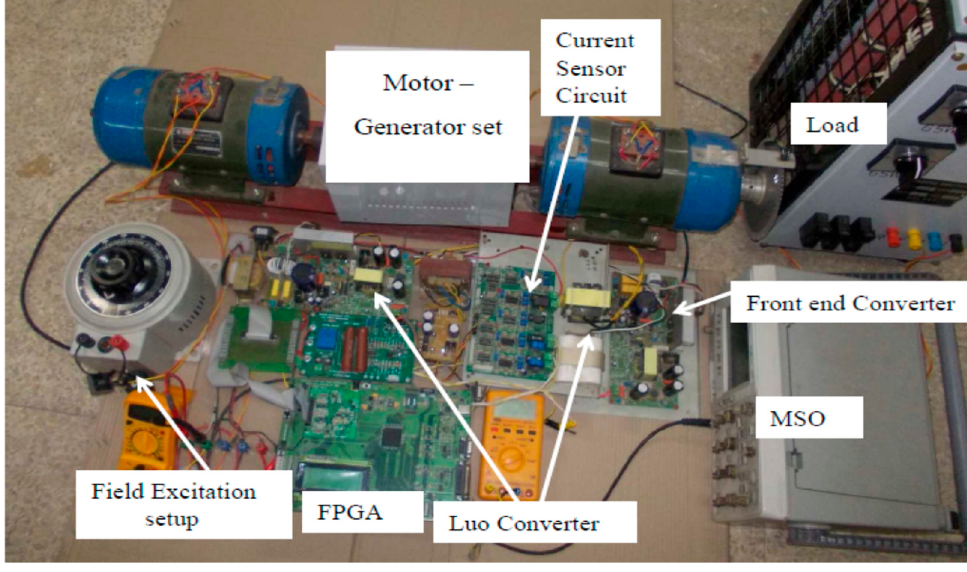
Figure 5. Hardware setup for the Luo converter-fed DC motor.